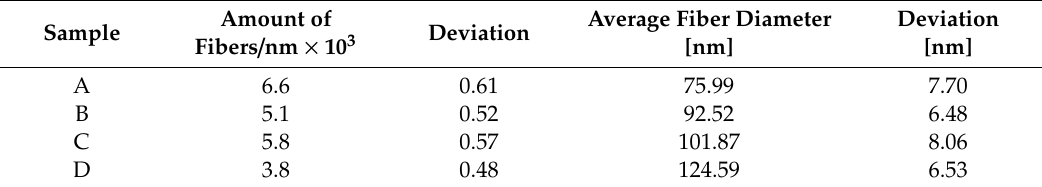
Table 4. Average values of diameters and number of coating fibers.